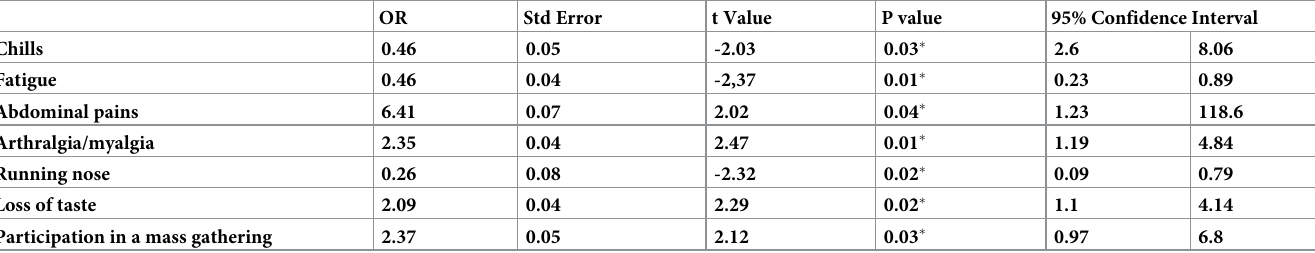
Table 2. Output for multivariable analysis of factors associated with a diagnosis of COVID-19.